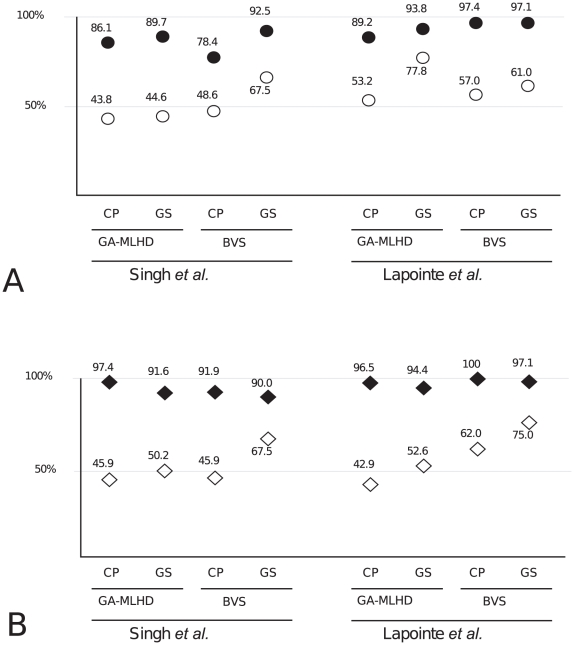
Accuracy and Tissue specificity of representative models.The predictive accuracy of the models developed using normal tissue
(panel A, filled circles) is comparable to those models developed using
tumour tissue (panel B, filled diamonds). When models developed using
normal tissue are trained and tested using data from tumour tissue, the
prediction power is decreased considerably (empty circles). Likewise,
tumour models trained and tested with data from normal tissue are also
non predictive (empty diamonds).